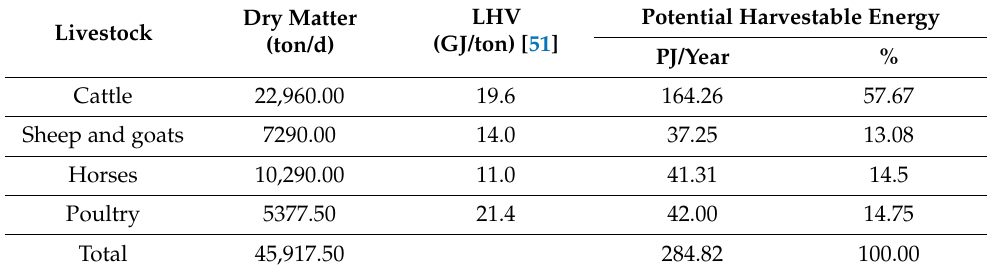
Table 5. Energy potential from